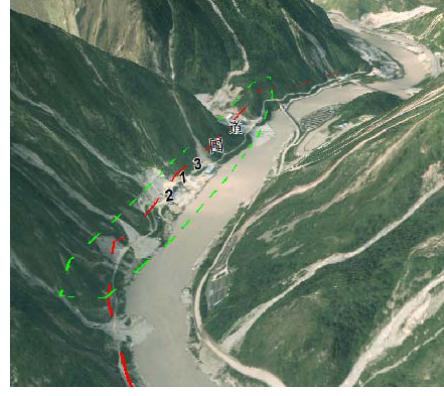
Figure 1. The Aerial Image After The Wenchun